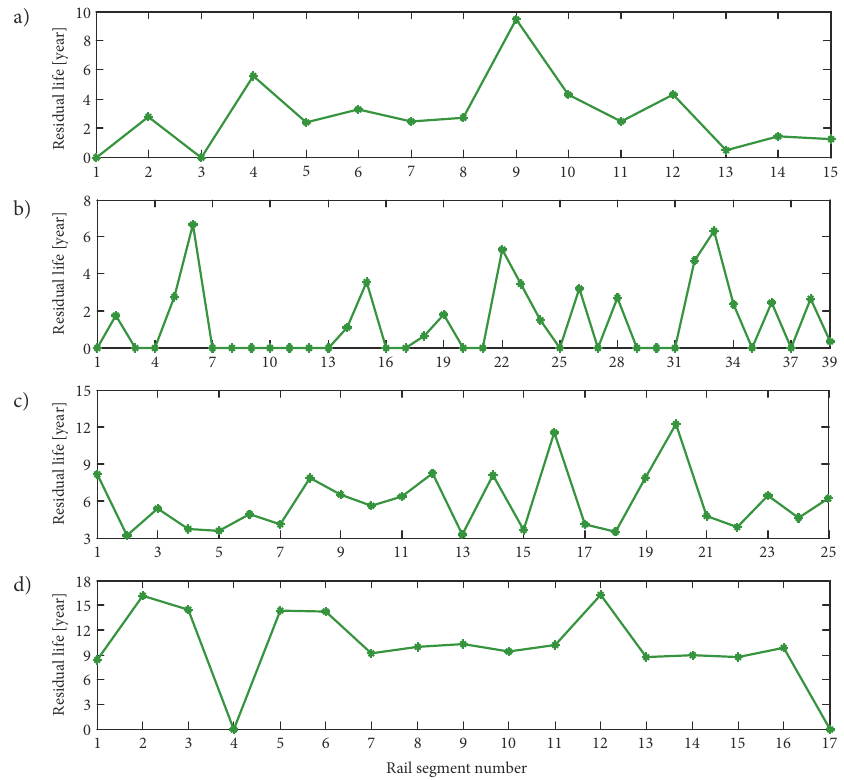
4. Estimated residual lives of rail segments: a – rail segments of Line 1; b – rail segments of Line 2; c – rail segments of Line 10; d – rail segments of Line